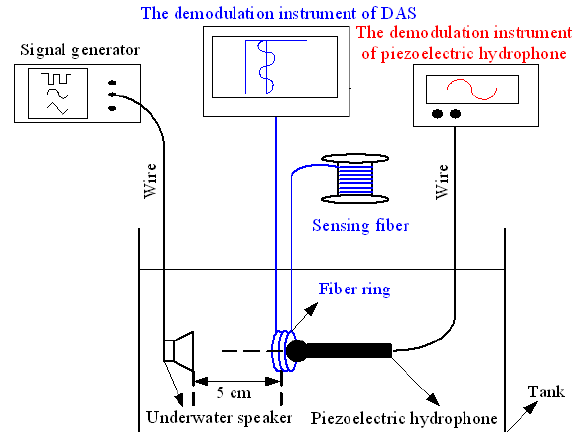
Fig. 4 Schematic diagram of underwater distributed acoustic testing experiment.